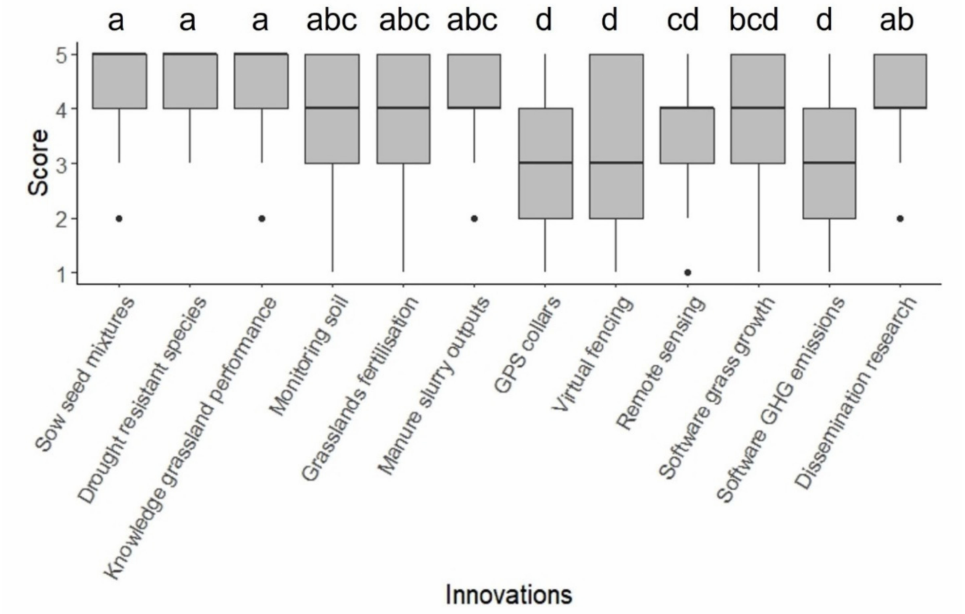
Figure 3. Boxplots of relevance given to grassland-related innovations. Different letters above the box- plots indicate significant differences in the relevance among innovations ( p < 0.05). Black centre line, median; box, interquartile range; box limits, lower and upper quartiles; whiskers, 1.5 × interquartile range; points,